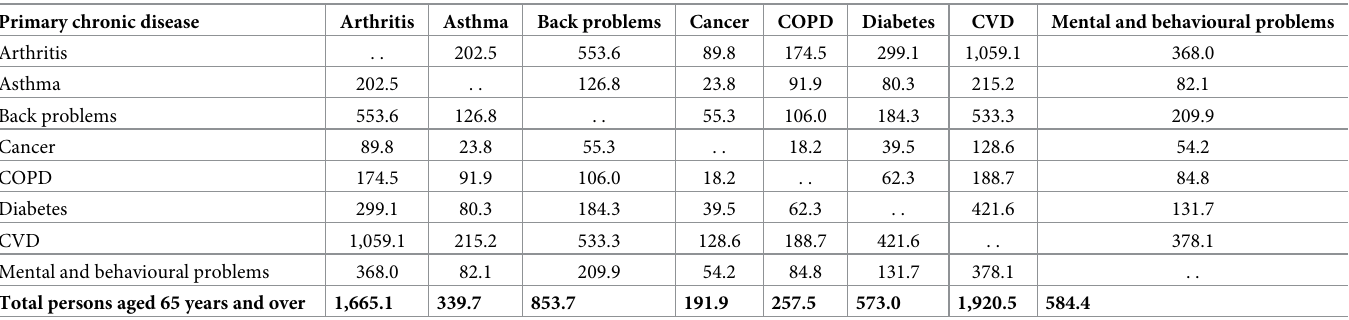
Table 4. Comorbidity matrix of chronic diseases in the Australian population aged 65 years and over (in 1000). Primary chronic disease